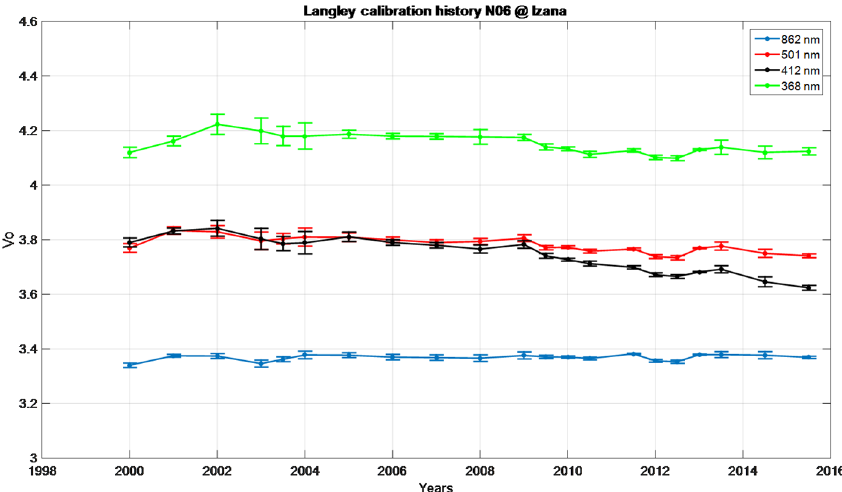
Figure 3. Long-term V o values for PFR-N06 at Davos and IZO for the four PFR channels. Bars indicated the standard error.